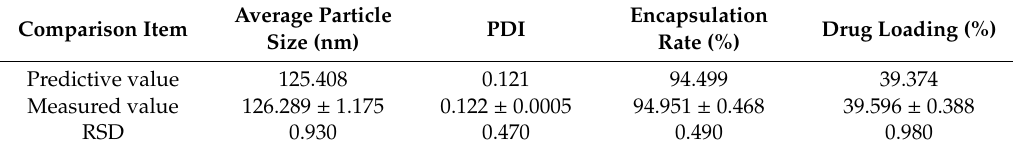
Table 4. Comparison of predicted and measured values ( n = 3, ⎯ x ± s).